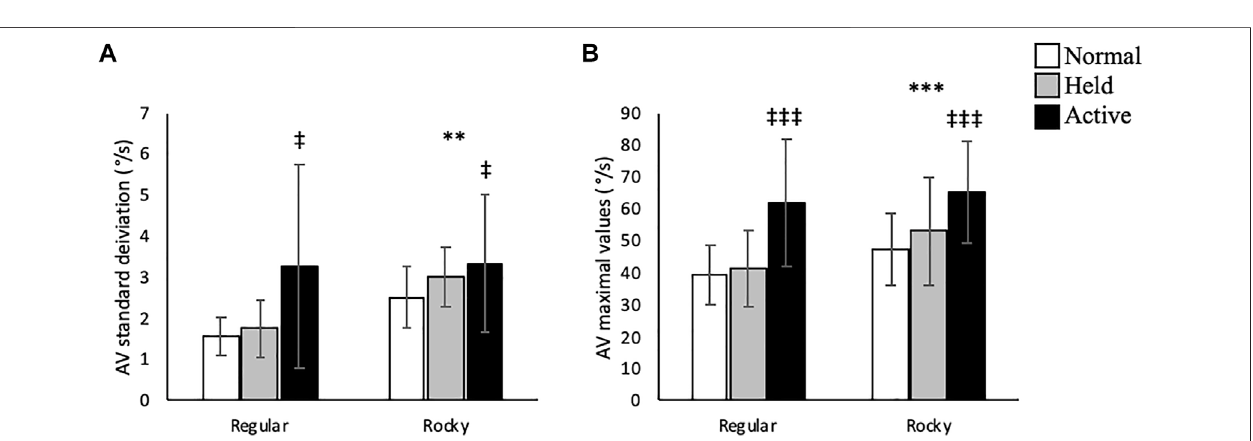
FIGURE8| Trunk linearvelocity (A) standarddeviation(m/s) and (B) maximalvalues(m/s) accordingtosurfacetypeforeach armconditioninthevertical direction. **and***showsthatrockysurfaceledtolargervaluesthanregularsurfaceat p < 0.01and p < 0.001,while ‡ and ‡‡‡ showsthatactivearmswingledtolargervaluesthan normal and held at p < 0.05 and p <